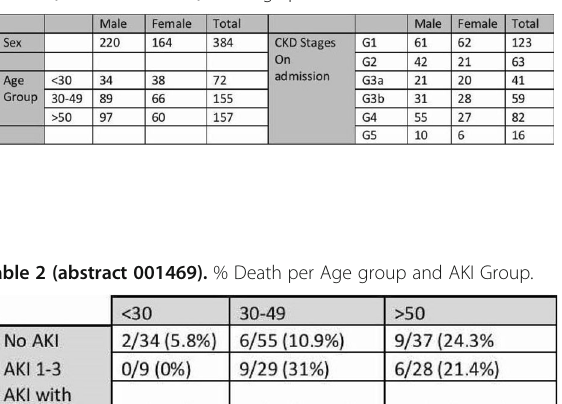
Table 1 (abstract 001469). Demographics for total 384 Patients.